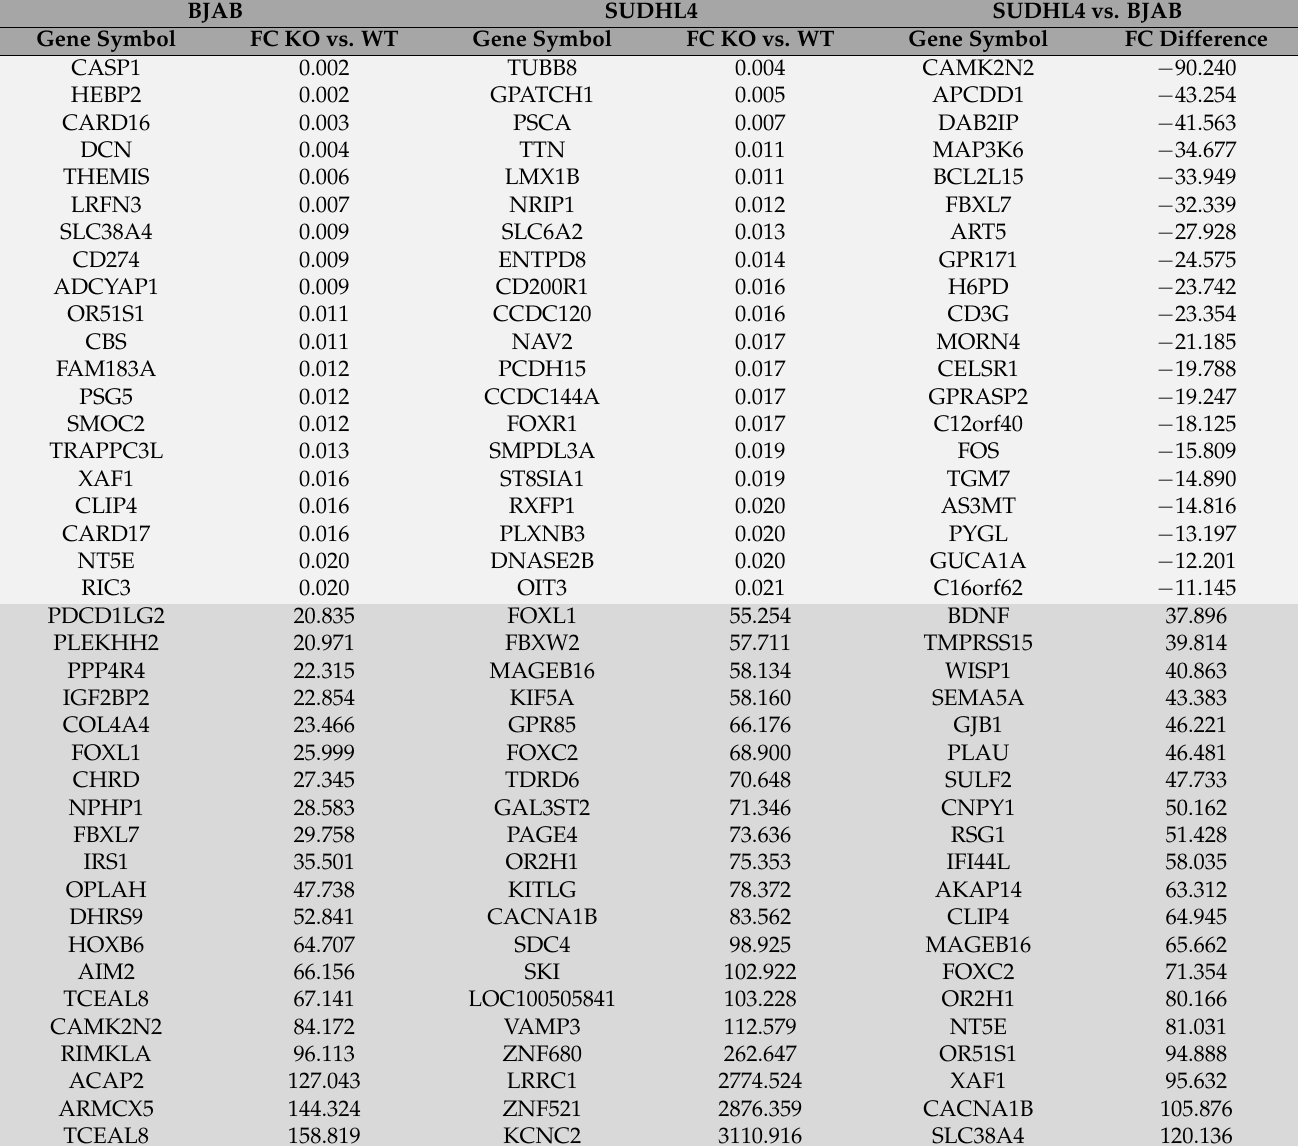
Table 1. The 20 most up- (dark grey) and down-regulated (light grey) genes in miR-142 knockout BJAB and SUDHL4 cell lines as well as the 20 most differentially expressed genes in the comparison of miR-142 knockout SUDHL4 vs. BJAB